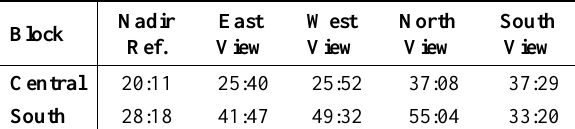
Table 13. Performance of individual hierarchical AT runs of the Munich Central and South blocks, all values in